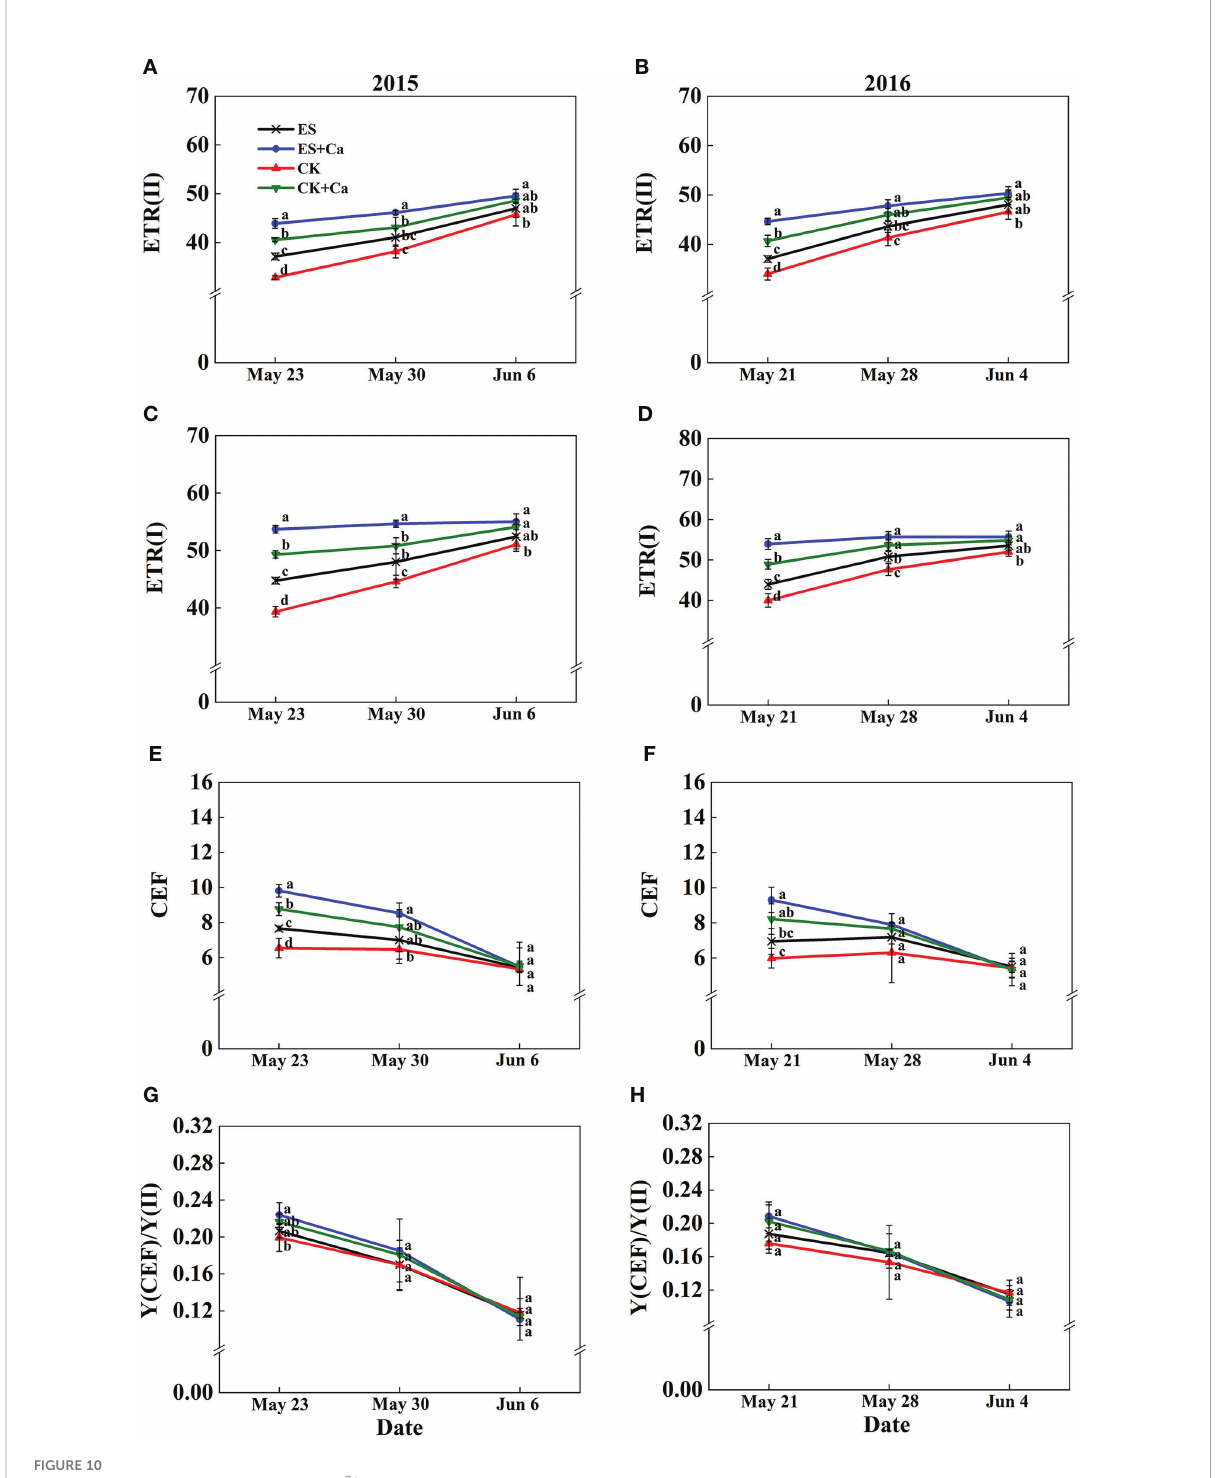
FIGURE 10 Effects of exogenous foliar calcium (Ca 2+ ) application on peanut PSII photosynthetic electron transport rate [ETR(II), A , B ], PSI photosynthetic electron transport rate [ETR(I), C , D ], cyclic electron fl ow around PSI (CEF, E , F ), the ratio of quantum yield of CEF to Y(II) [Y(CEF)/Y(II), G , H ] under early and normal sowing scenarios. Values are means ± SD (n = 3). Different letters indicate signi fi cant differences according to Duncan ’ s multiple range tests ( p <